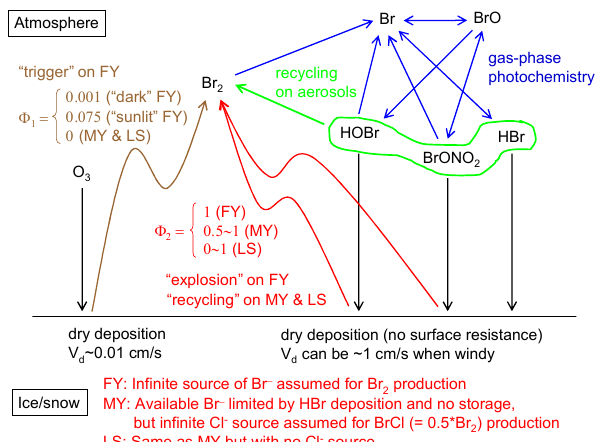
Fig. 1. A schematic of the basic scenario for bromine chemistry in the atmosphere and air-ice/snow interactions of reactive bromine species in the present simulations. FY, MY and LS denote the snow- pack on the FY sea ice, the MY sea ice and the land surface, respec- tively. Presented values for the molar yields ( 8 1 and 8 2 ) of Br 2 from the dry deposition of O 3 , HOBr and BrONO 2 are valid for the model runs 3–5, whereas the values are somewhat different for other model runs (see Table